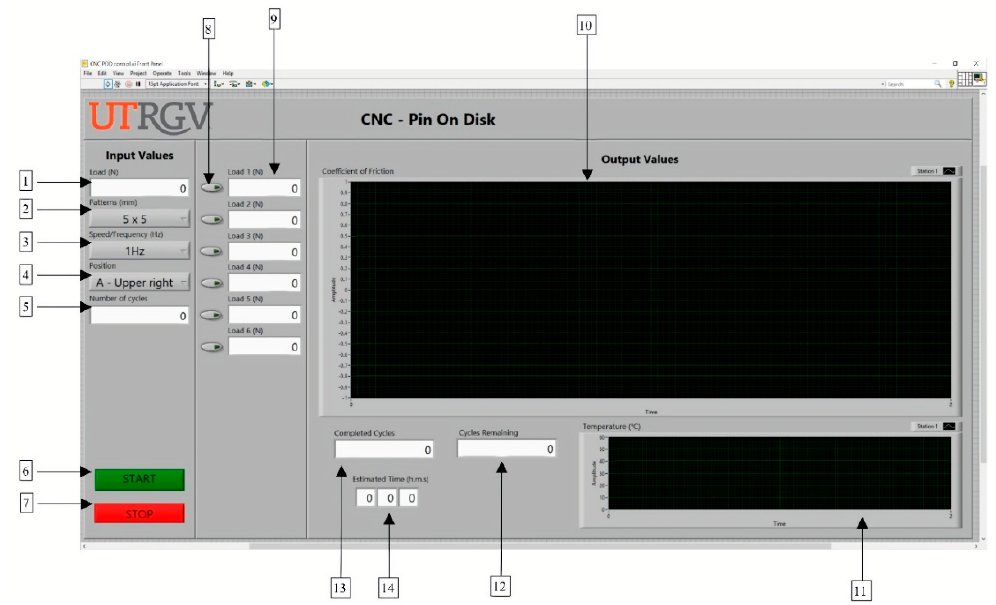
Figure 5. LabVIEW Interface (Virtual Instrument).